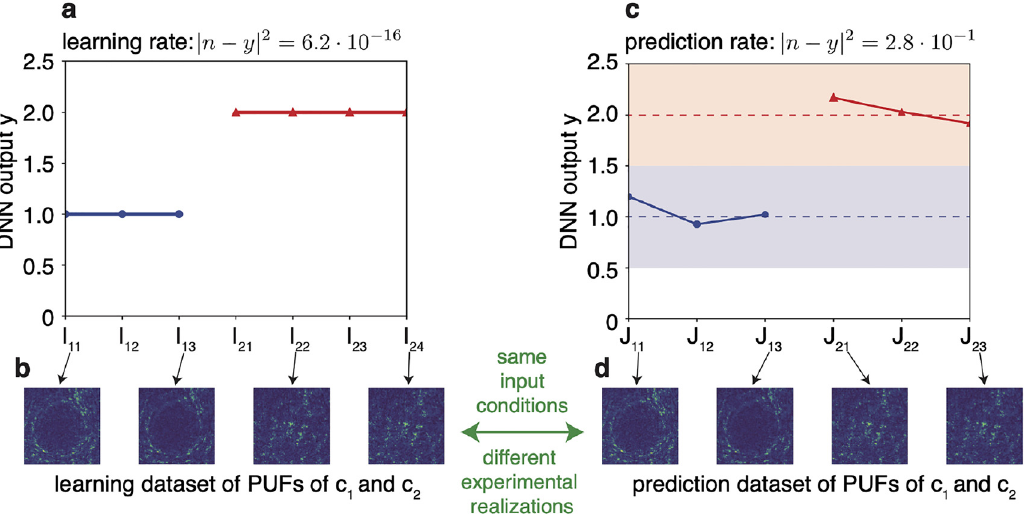
Figure 3: Deep neural network training and key association.